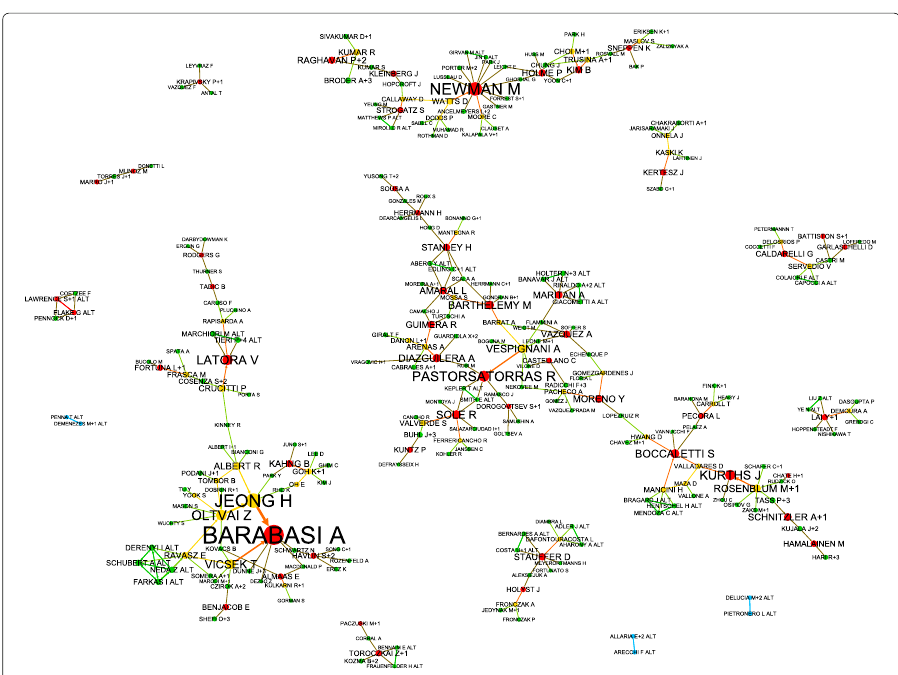
Fig. 20 Net Science zone network. The zone network provides information on the hierarchy of sub-zones, multi-ego zones, alternative zones, and zones in overlaps. Thus, the nodes represent zones and the directed edges point from the sub-zone to its closest super-zone (or to more super-zones when the zone is inside their overlap). The node size corresponds to the number of nodes in the zone; the edge weight corresponds to the number of nodes in the sub-zone. It can be seen that the Net Science network, from the perspective of the zones, has partitioned into differently-sized clusters which uncover the structure of ego-centered cooperating teams and their sub-teams. Two clusters have distinct centers with large zones (Barabási and Newman). On the contrary, the large cluster in the middle contains rather small